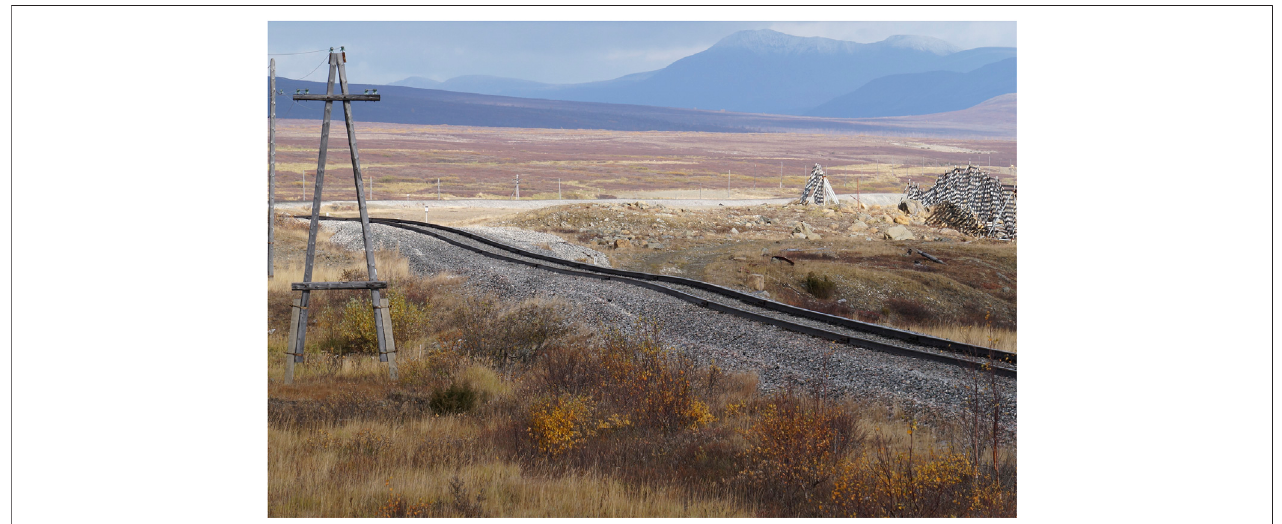
FIGURE 2 | Railroad deformation associated with permafrost degradation along the North Russian Railway close to the Khanovey fi eld site at the western foothills of the Ural Mountains.